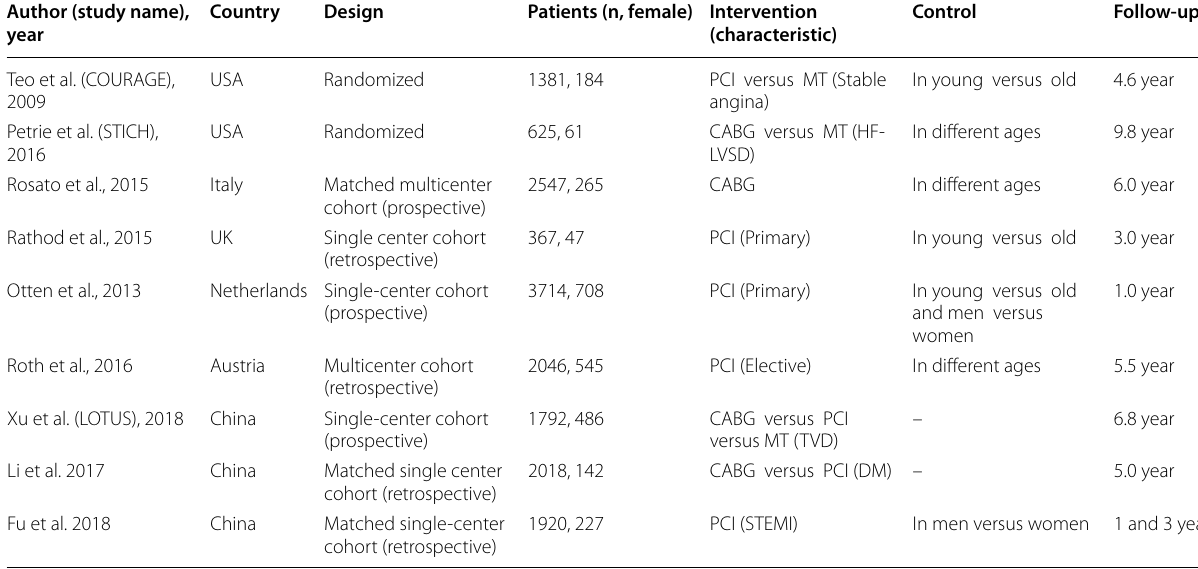
Table 4 Characteristics of included studies